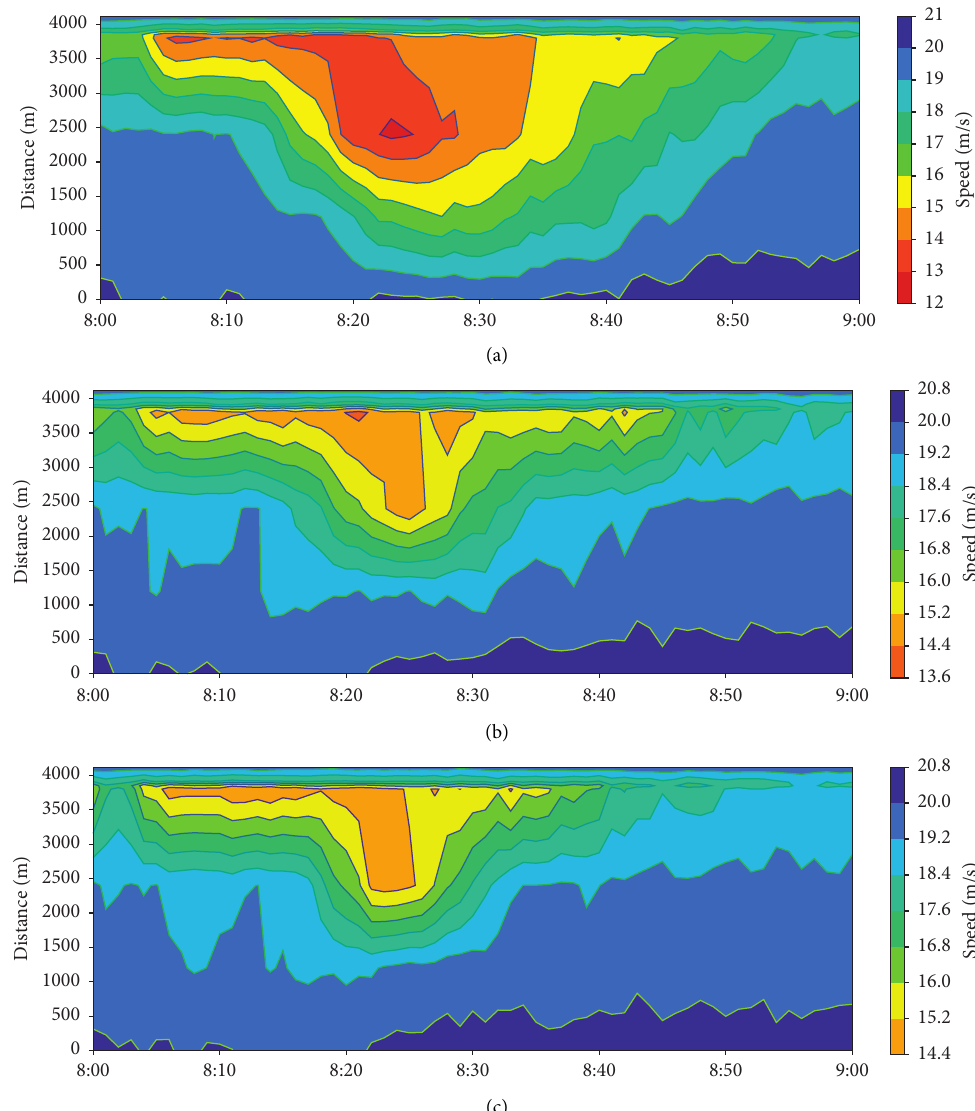
Figure 10: Temporal-spatial distribution of speed in (a) no-control; (b) PI-ALINEA; (c) DRL.